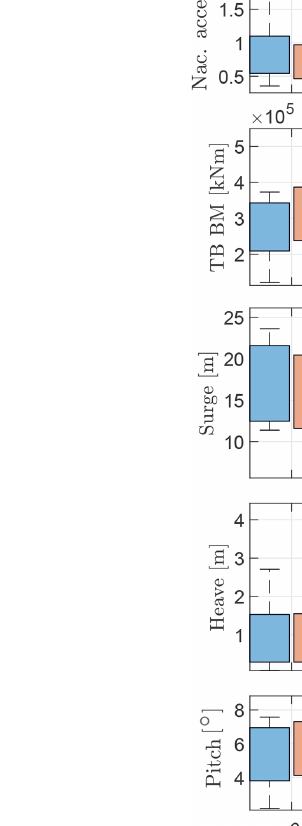
maximum values for each seed associated with the specific environmental